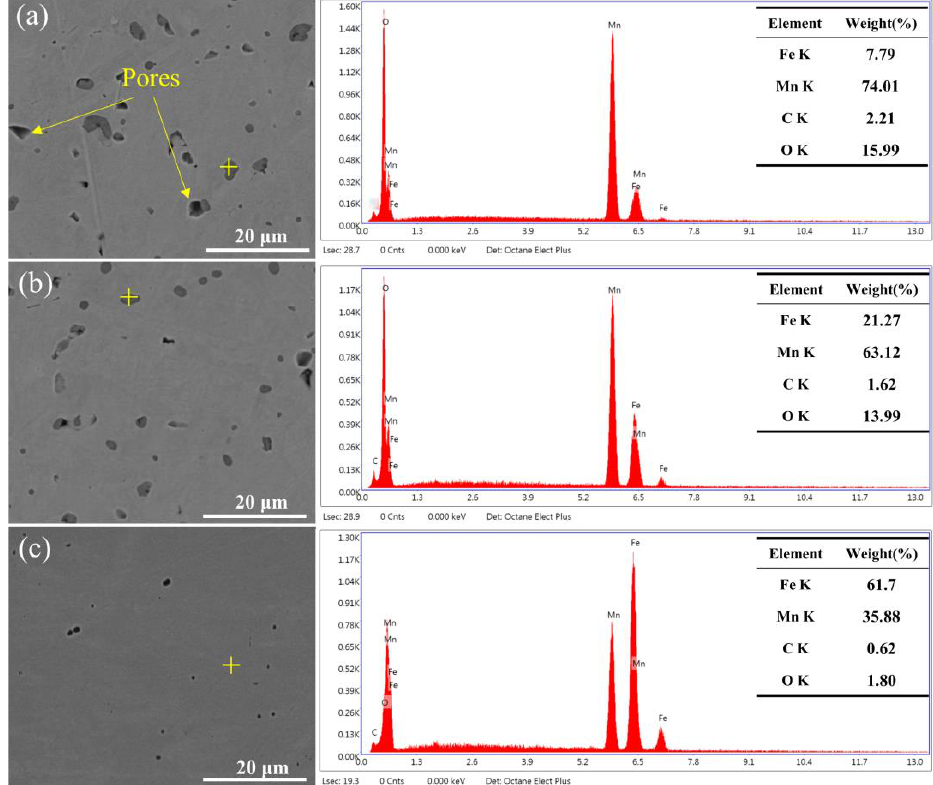
Figure 3. SEM images and EDS analysis of alloys: ( a ) VS; ( b ) PS; ( c )